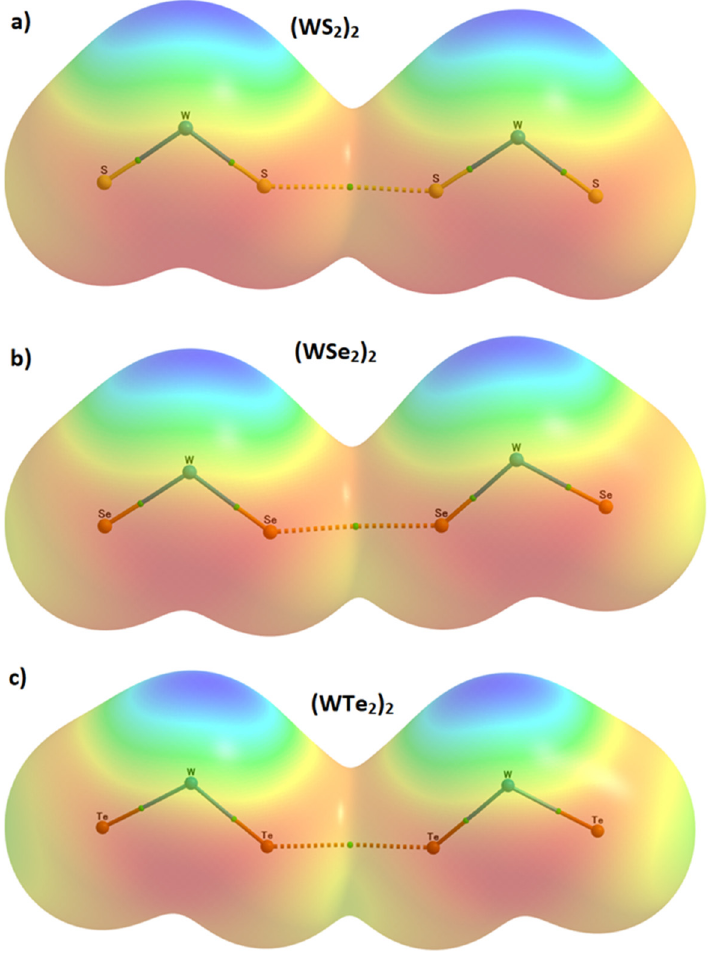
Figure 9. The 0.001 a.u. isodensity envelope mapped potential on the molecular surface of the three dimers, overlaid in the QTAIM bond paths and critical points, obtained using M06-2X/Aug-cc-pVTZ(-PP): ( a ) (WS 2 ) 2 ; ( b ) (WSe 2 ) 2 ; ( c ) (WTe 2 ) 2 , suggesting no van der Waals gap existing between bonded chalcogen atoms in the intermolecular region since they are overlapped with each other. Color codes: red ( − 11.0 a.u.); yellow (+2.6 a.u.), green (+16.1 a.u.); cyan (+29.7 a.u.); and blue (+43.3 a.u.); 1 a.u. = 627.5 kcal mol − 1 .